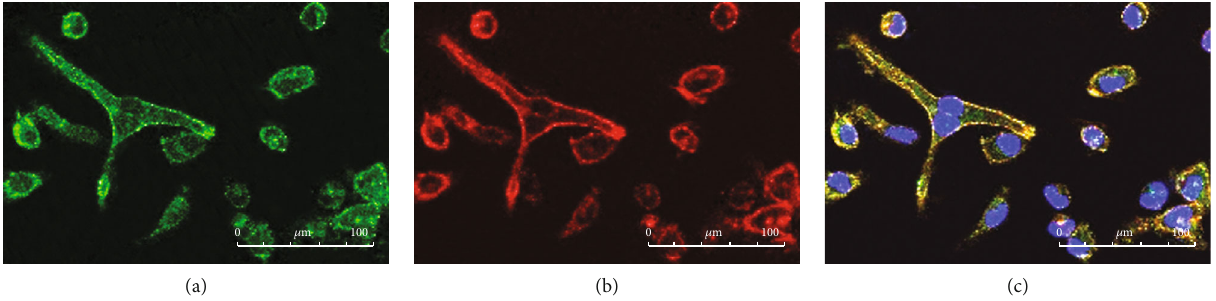
Figure 4: Immuno fl uorescence of TLR4 and CD14 in the control group after LPS stimulation. (a) Monocytes were identi fi ed by CD14. A few cells changed. (b) TLR4 was mainly expressed on the cell membrane. (c) TLR4 and CD14 were expressed in mononuclear cells without LPS stimulation.